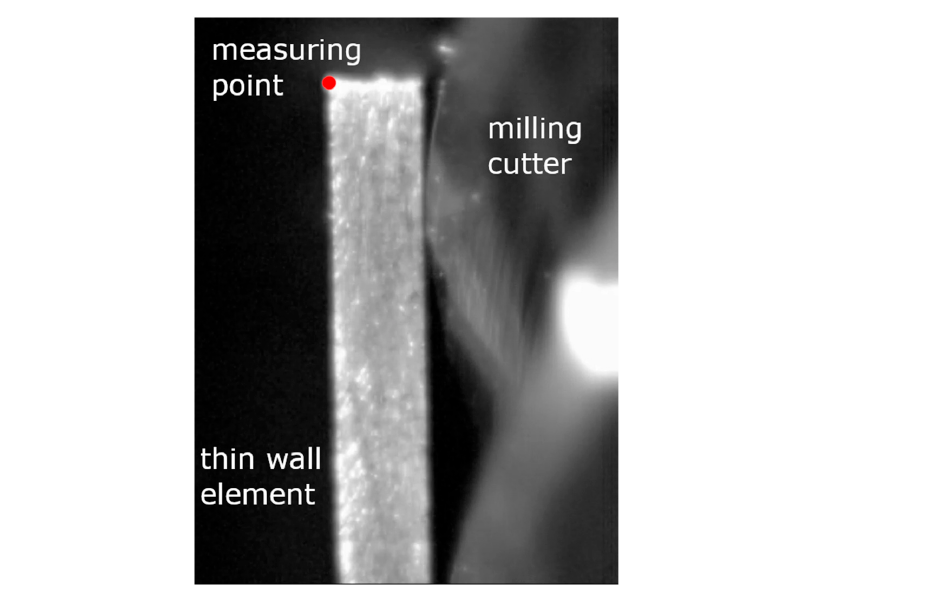
Figure 4. A frame of film recorded with a high-speed camera while milling a thin wall.